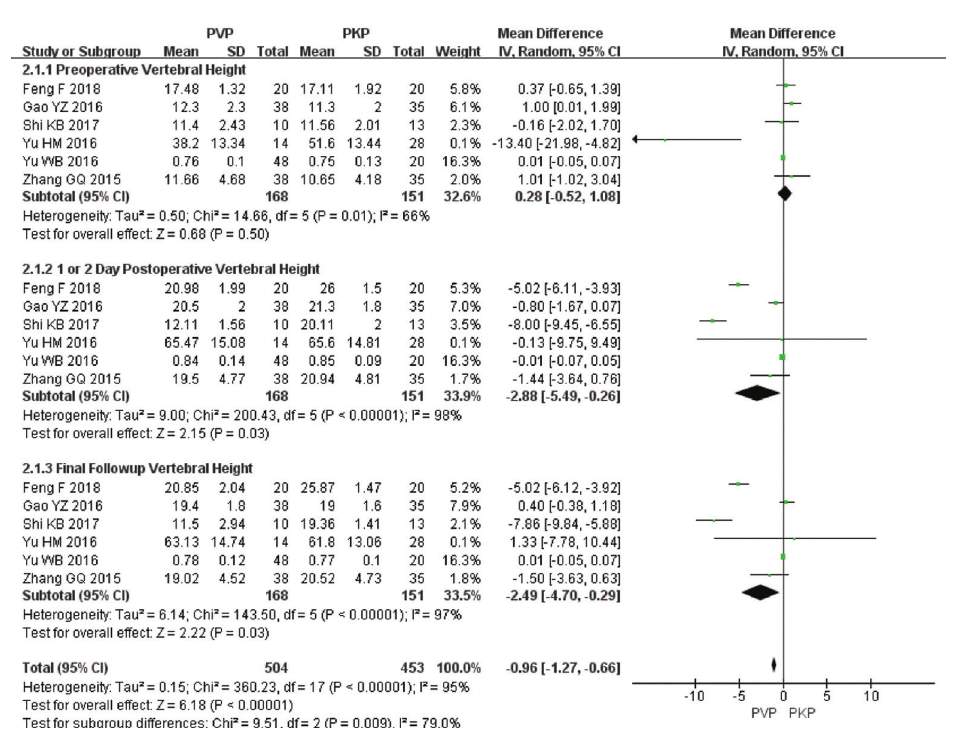
Figure 3. Forest plot to assess anterior vertebral body height between two